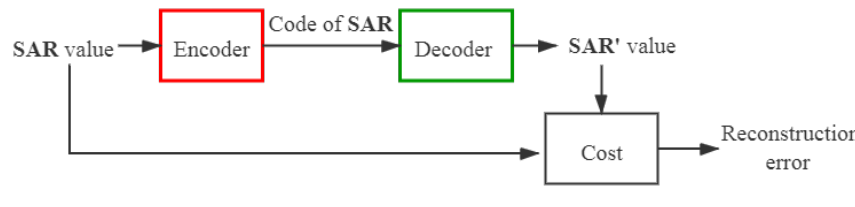
Figure 5. Structure of an autoencoder neural network.